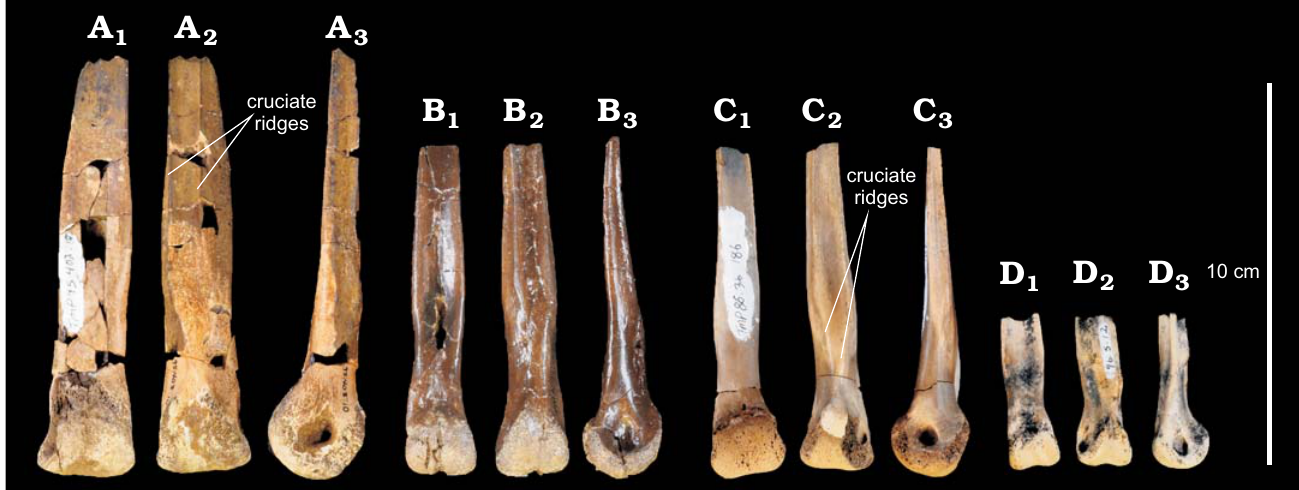
Fig. 8. Elmisaurine dinosaur Leptorhynchos elegans (Parks, 1933) from the Upper Campanian Dinosaur Park Formation, Dinosaur Provincial Park, Alberta, Canada. A . TMP 1995.403.0010. B . TMP 1984.163.0036. C . TMP 1986.036.0186. D . TMP 1996.5.12. Isolated metatarsals III in anterior (A 1 – D 1 ), posterior (A 2 –D 2 ), and lateral (A 3 –D 3 )